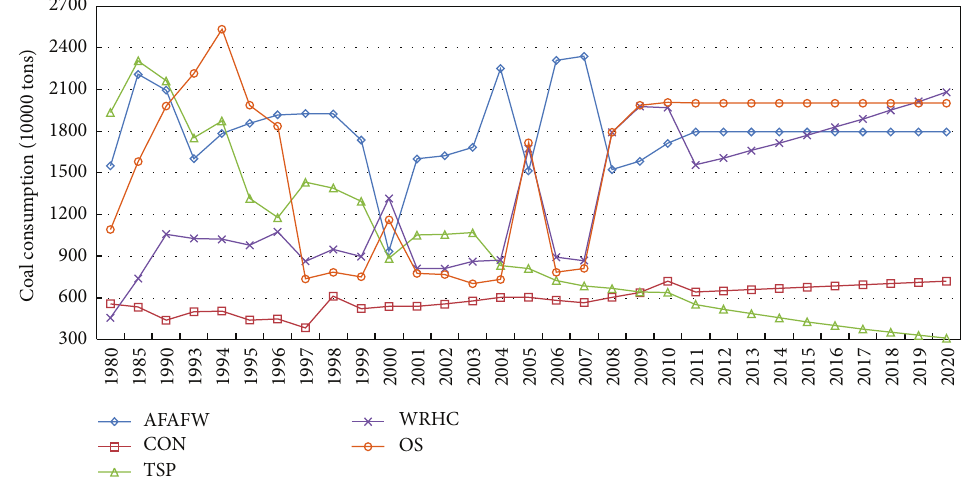
Figure 5: Changes of other sectors’ coal consumption. Table 2: Formulae for recursive calculations, point forecasts, and parametric estimated value on sector by ETS method. Variables Forms Models and parameters